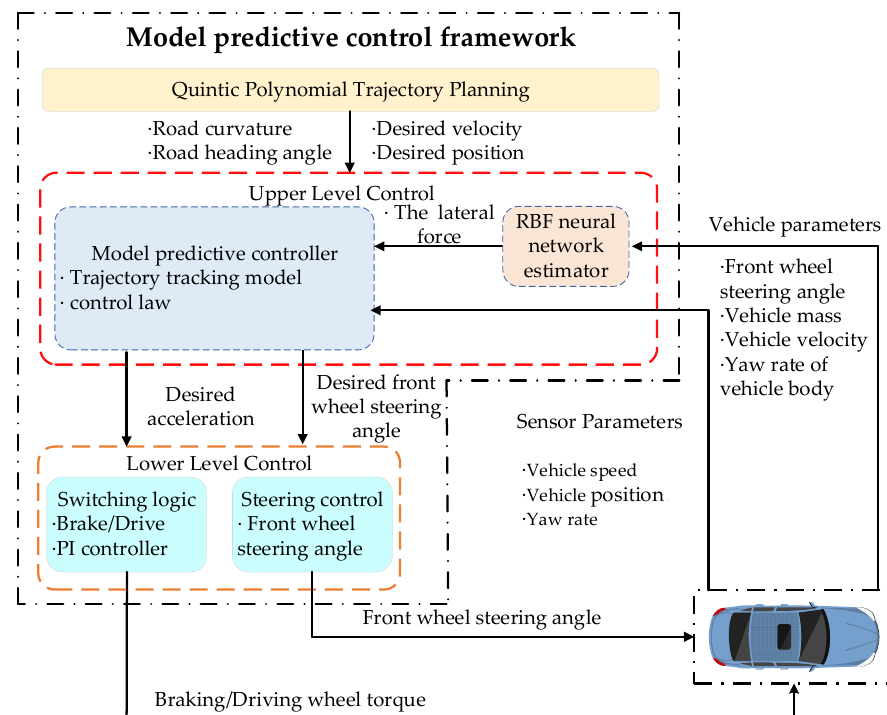
Figure 1. Hierarchical control structure of the trajectory tracking control system.